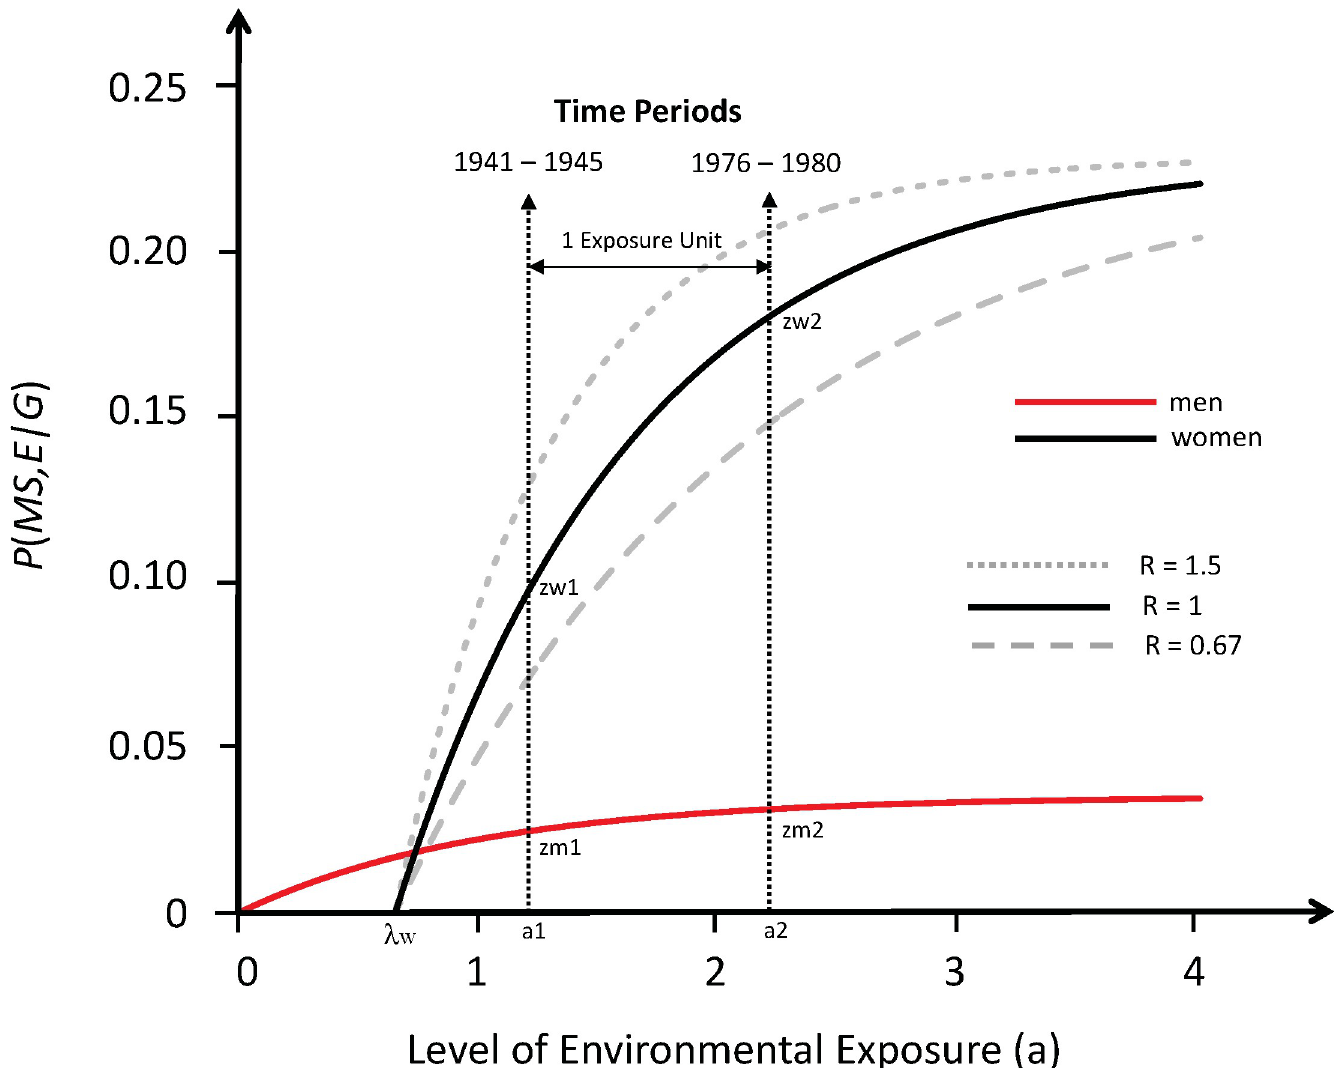
Fig 4. Response curves for the likelihood of developing MS in genetically susceptible men and women with an increasing probability of a sufficient environmental exposure { P ( E )}, assuming proportional hazards ( see #7 ). Response curves are derived from the change in the ( F : M ) sex-ratio over time in Canada [56] and using the estimates for P ( MS ) 2 & P ( G ) estimated in the Text . The probability of getting MS in a genetically-susceptible individual–i.e., P ( MS , E | G )–is shown on the y-axis . The exposure level { P ( E )} for the population is shown on the x-axis using transformed “exposure units” ( a )– see #7 , Text . Labels for points Zw = P ( MS , E | G , F ) and Zm = P ( MS , E | G , M ) are provided at time-points ( 1 ) and ( 2 ). One “exposure unit” is defined arbitrarily as: ( a 2 − a 1 ) for men and ( a 2 app − a 1 app ) for women ( see #7 ). Solid-line plots have been constructed using the known values of ( Zw 2 ) and ( Zm 2 ), estimating that: P ( F | MS ) 2 = 0.66 ( Table 3; Fig 3 ), together with the estimates of: { C = 0.6}, { R = 1}, { P ( G ) = 0.044} & { P ( F | G ) = 0.25}– the latter two parameters being valued in the middle of their predicted ranges ( see , Text ). The limiting values for ( Zm ) and ( Zw ) are: ( c = 0.035) and ( d = 0.228), respectively. Increasing the estimate of P ( F | G ) will reduce the separation of the response curves by lowering the plateau for women and raising it for men; increasing the estimate of P ( F | MS ) 2 will increase the separation of between the curves in men from women for the opposite reason; increasing the estimate of P ( G ) will reduce the plateaus of both response curves. Response curves for women under conditions ( R = 0.67) and: ( R = 1.5) are also depicted and are shown in grey lines (dashed and dotted, respectively). Changes to the value of ( C ) will slightly alter the units of the y-axis . As seen in the Figure , men have a lower threshold for developing MS compared to women ( see #7 , Text ), and changes to the value of ( R ) alter how quickly the curves reach their plateau (limit). If the hazard is not proportional, for women, each of the points ( Zw 1 , Zw 2 , Zm 1 , and Zm 2 ) would be the same as depicted for ( R = 1), although the scale of the x-axis for the two exponential curves would be transformed non-linearly and, thus, the response-curve in men could not be plotted on the same graph as women. Moreover, the x-intercept for the curve in women would be at ( a app = λ w = 0). Nevertheless, the limiting values ( c ) and ( d ) would be unchanged and, under any circumstances, women (relative to men) would still be seen to exhibit a greater responsiveness to those changes in environmental exposure, which have taken place between the two time- periods. If some cases of MS were “purely genetic” (i.e., P ( E | M ) = 0, or P ( E | F )= 0 or both were not possible), this could elevate the zero-point on y-axis for “environmental” MS to the intersection of the curves for men and women ( see Text ) and this would make the threshold difference then disappear (i.e., λ = 0) – see #7 , Text